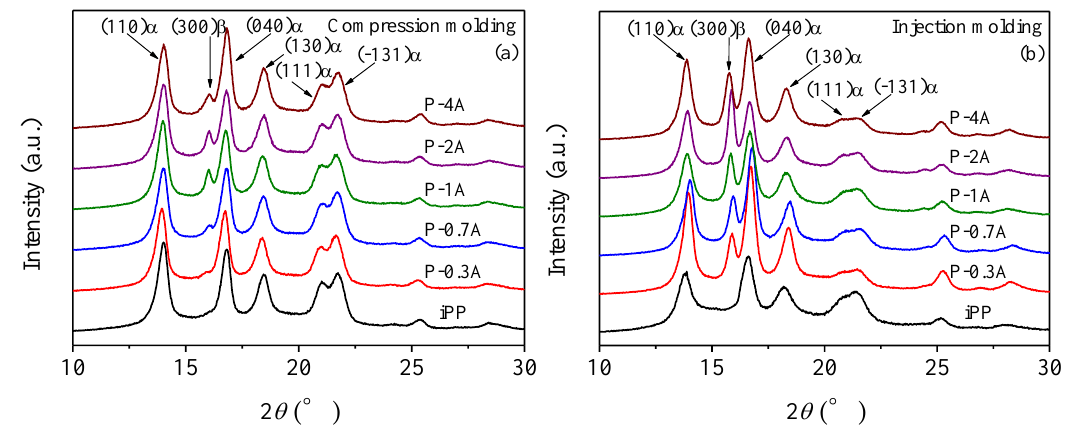
Figure 6. WAXD patterns of pure iPP and iPP/ABS blends prepared by compression molding ( a ) and injection molding ( b ).